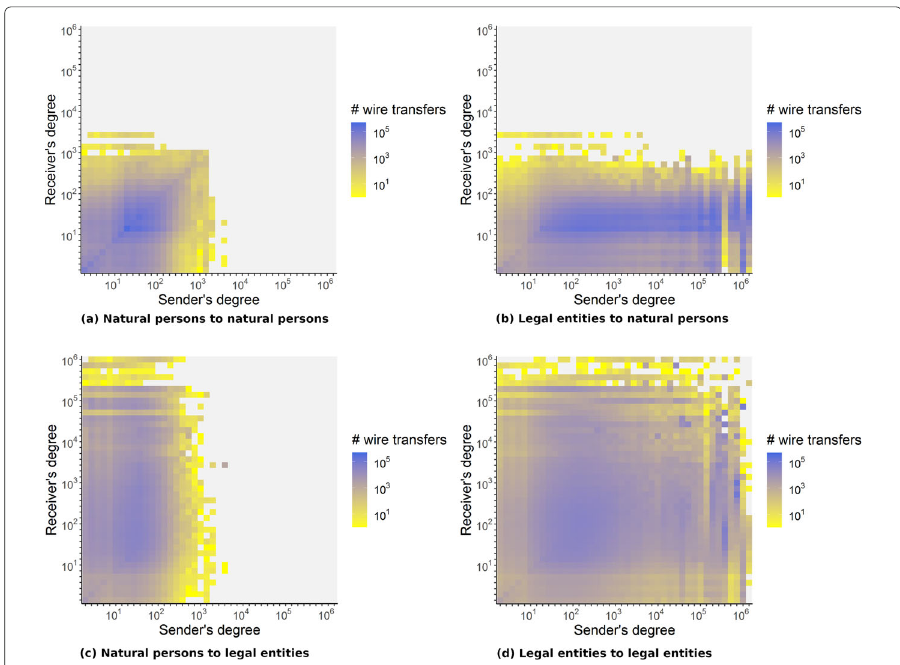
Fig. 11 Degree correlation heat maps: these heat maps have been created filtering the declared type (natural person or legal entity) of the payees and the payers. Again, x axes represents sender nodes’ degree, and y axes is the receiver nodes’